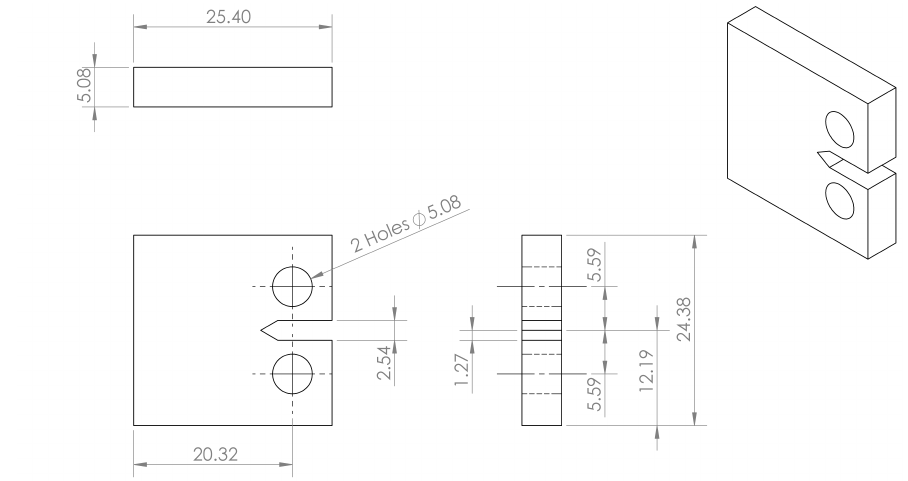
Figure 2. Compact tension (CT) specimen geometry used for the crack detection study. All dimensions are in mm. The FBG sensors were embedded perpendicular to the notch